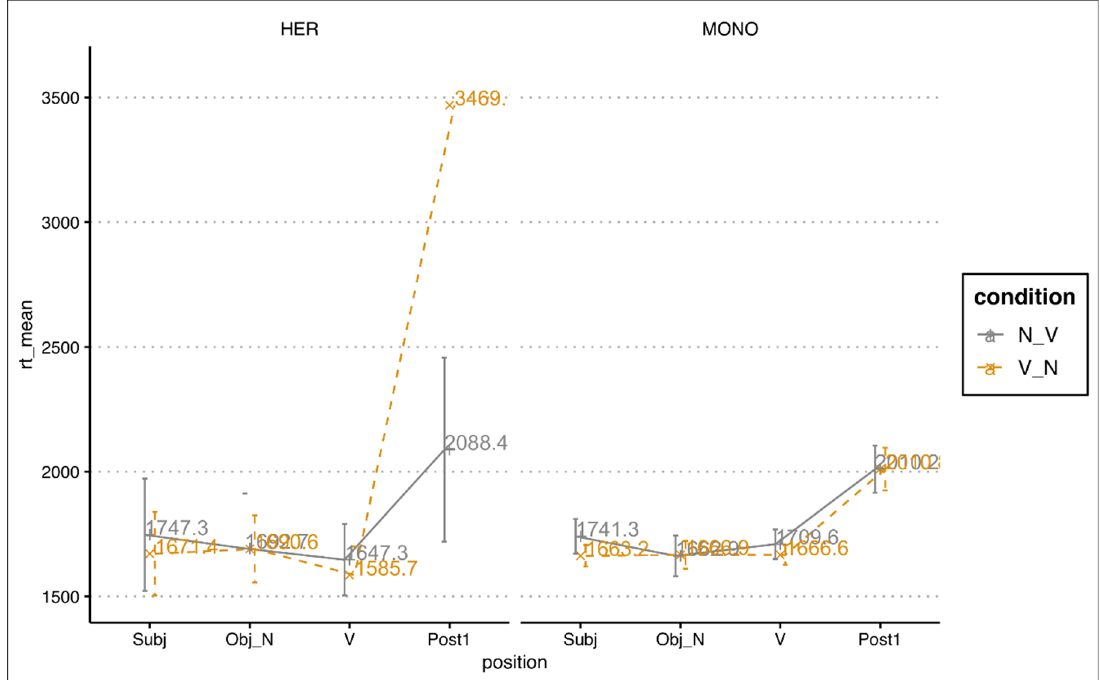
Figure 2. HS and baseline mean RTs of NPs in Conditions 3 and 4. Table 4. Response times: simple effects by group.